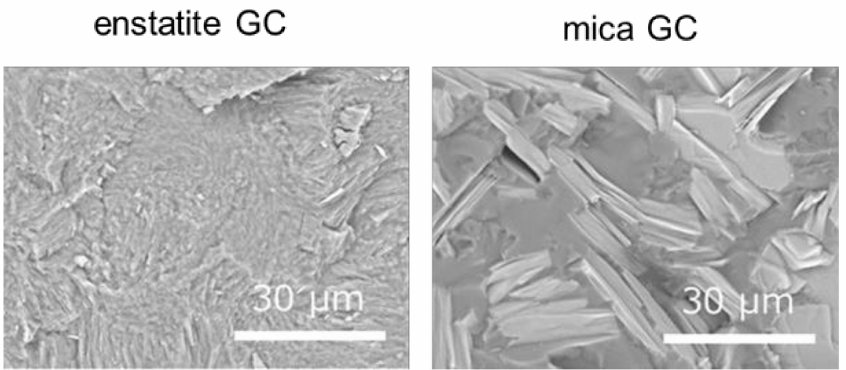
Figure 11. SEM images of the fractured surface of the reference